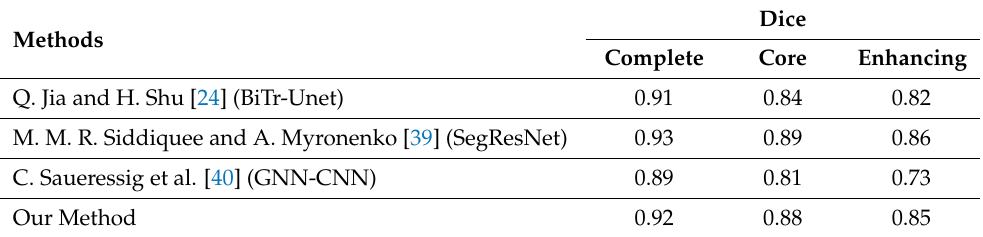
Table 6. On the BRATS 2021 Challenge dataset; comparison with different approaches.